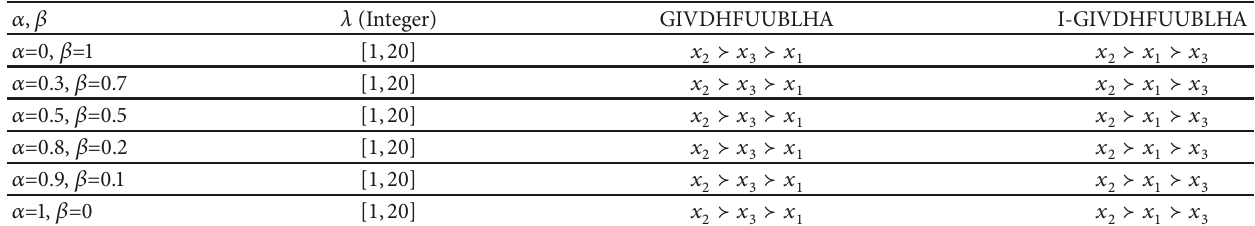
Table 7: Ranking results obtained by GIVDHFUUBLHA and I-GIVDHFUUBLHA along with 𝛼, 𝛽 , and 𝜆 . 𝛼, 𝛽 𝜆 (Integer) GIVDHFUUBLHA I-GIVDHFUUBLHA